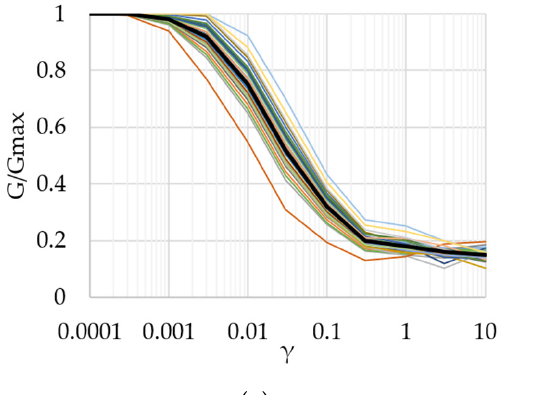
( b ) Figure 14. Probabilistic soil properties profiles: ( a ) soil S-wave velocity profile 1; ( b ) soil damping profile. The G- γ and D- γ linear-equivalent soil behavior curves are each generated using a one-dimensional random field, with large correlation lengths (slow variations) [55]. The Seed–Idriss curves (Figure 6) are used as the base (mean) values, along with the parame- ters from Table 3. Table 3. Probabilistic G- γ and D- γ curve generation parameters [49]. Segment